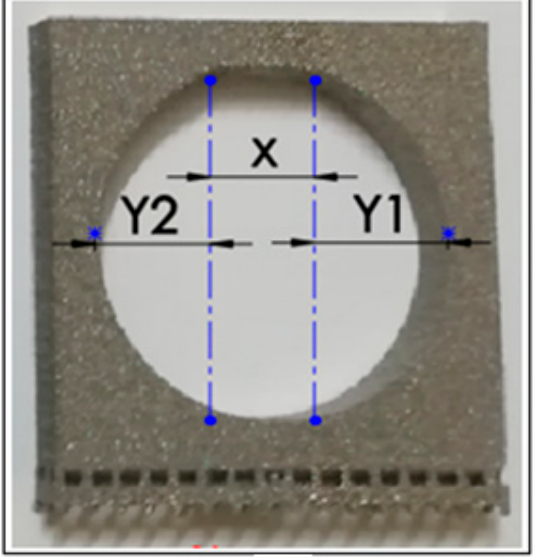
Figure 18. Deformation and self-supporting regions in overhanging holes.